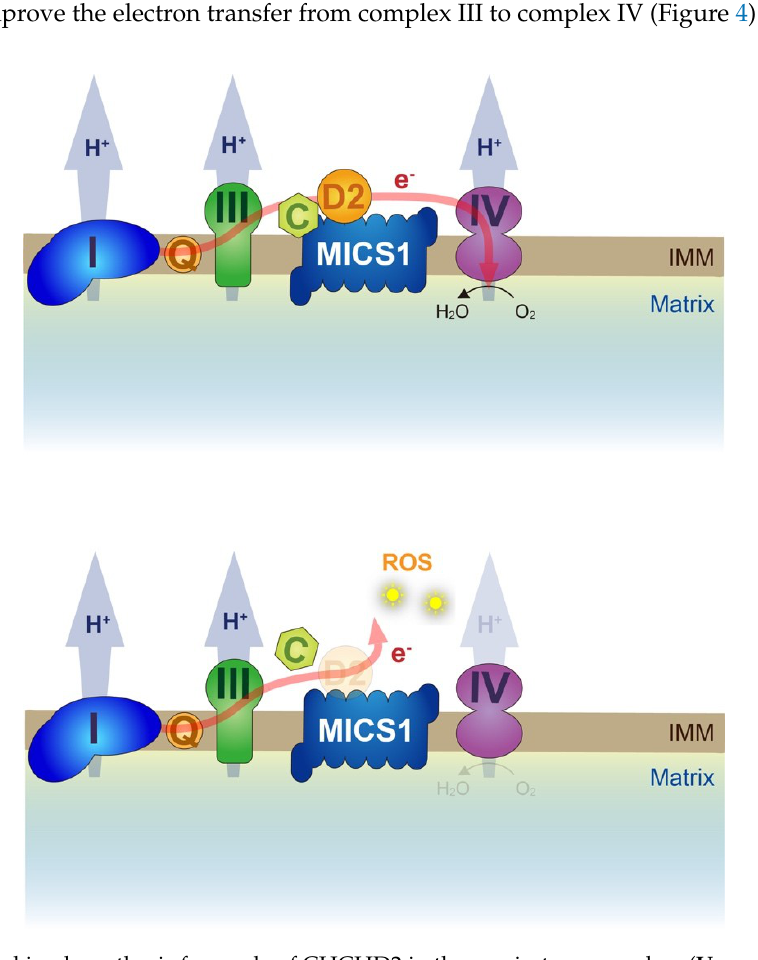
Figure 4. Working hypothesis for a role of CHCHD2 in the respiratory complex. (Upper) CHCHD2 (D2) along with MICS1 retains cytochrome c (c) in the respiratory complex, which stabilize electron flow from complex III to complex IV. (Lower) Loss of CHCHD2 destabilizes cytochrome c, leading to electron leak and subsequent ROS generation. IMM, inner mitochondrial membrane.